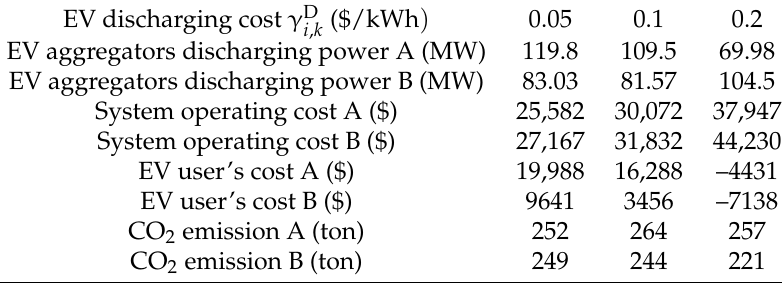
Table 4. Contrast of two strategies under different discharging prices at